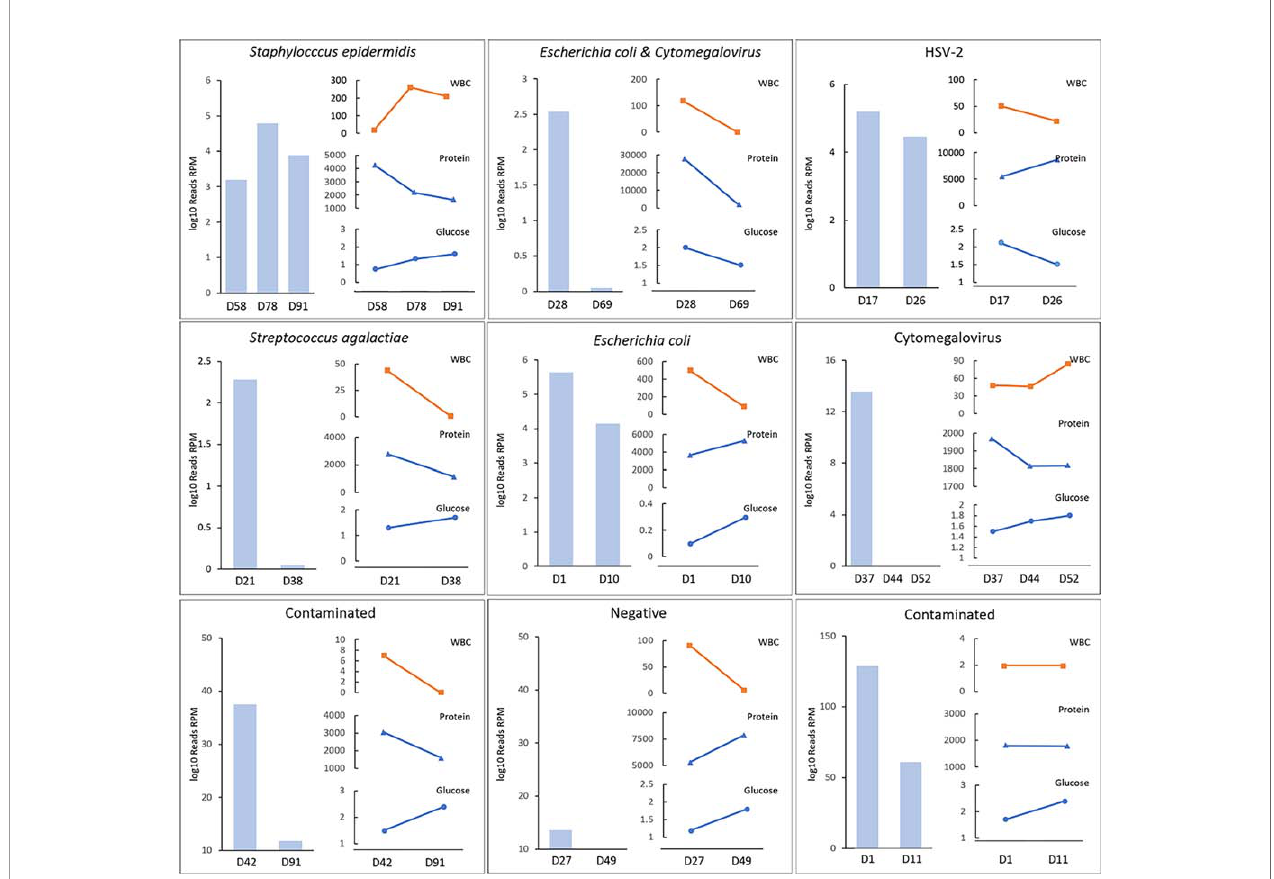
FIGURE 3 | The semiquantitative value of mNGS in the dynamic surveillance of CNS infections. HSV denotes herpes simplex virus. The horizontal axis represents patients ’ day of life when mNGS was conducted. Case1 was S.epidermidis . Case 2 was E.coli and cytomegalovirus. Case3 was HSV-2. Case 4 was S.agalactiae , Case 5 was E.coli , Case 6 was cytomegalovirus, Case 7 & 9 were diagnosed as contaminated although reads were detected, and Case 8 was negative. Case 8 was clearly diagnosed with GBS meningitis and treated with penicillin for 19 days in the fi rst hospital. He was sent to our hospital after complications occurred. However, two consecutive mNGS tests were negative, and the CSF WBC count and protein and glucose levels were always